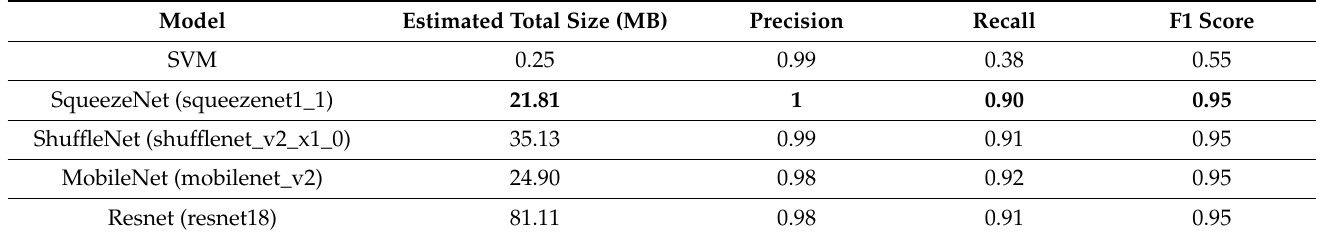
Table 1. Comparison of SVM classifier with various deep learning architectures for NLC classification.